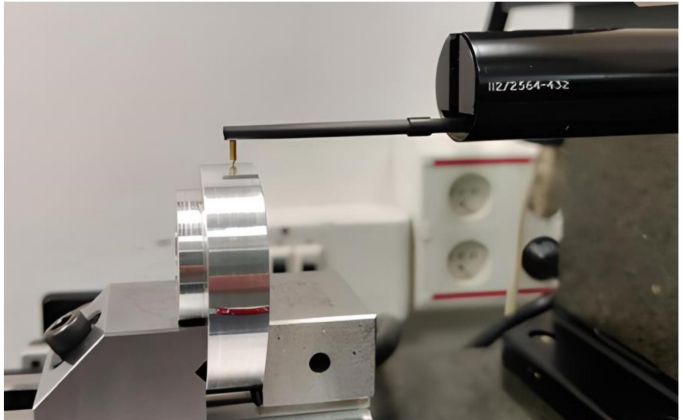
Figure 14. Roughness measurement of the working face of a machined